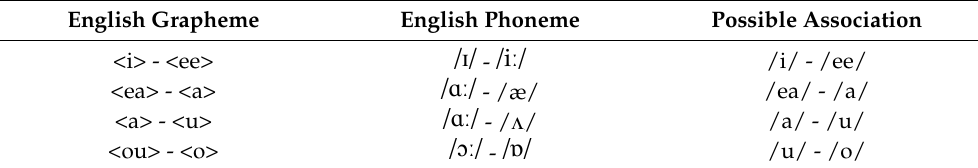
Table 1. Target English graphemes and phonemes and possible association of English graphemes with Greek phonemes by the Greek learners of English.